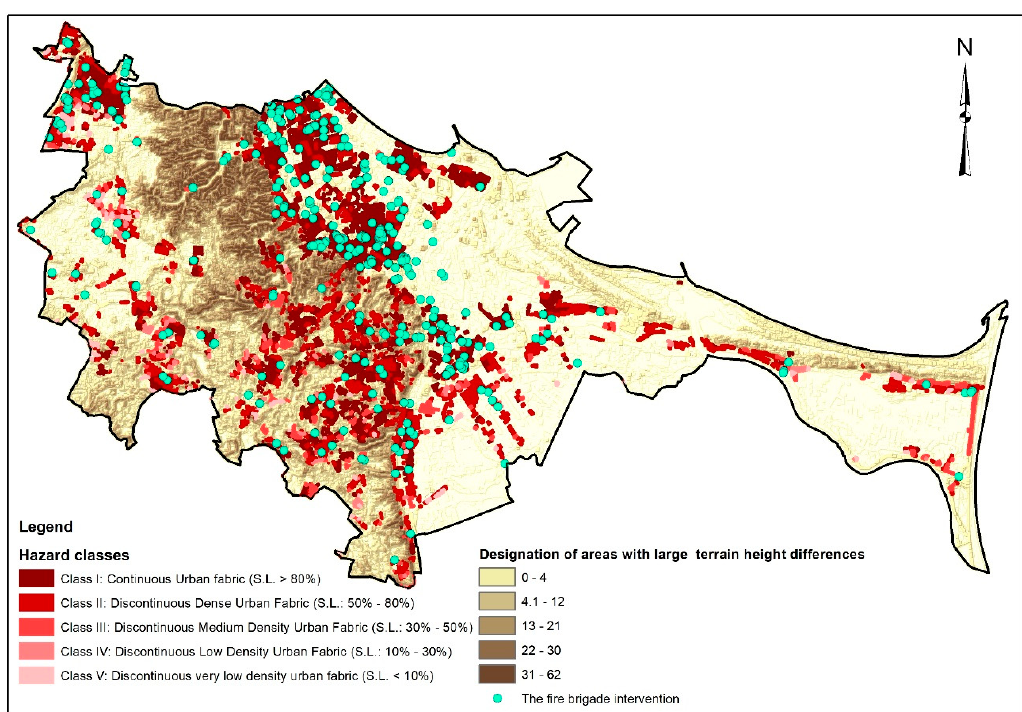
Figure 12. Interventions by the fire brigade against the background of the results for the four rainfall flooding predictors in the study area.